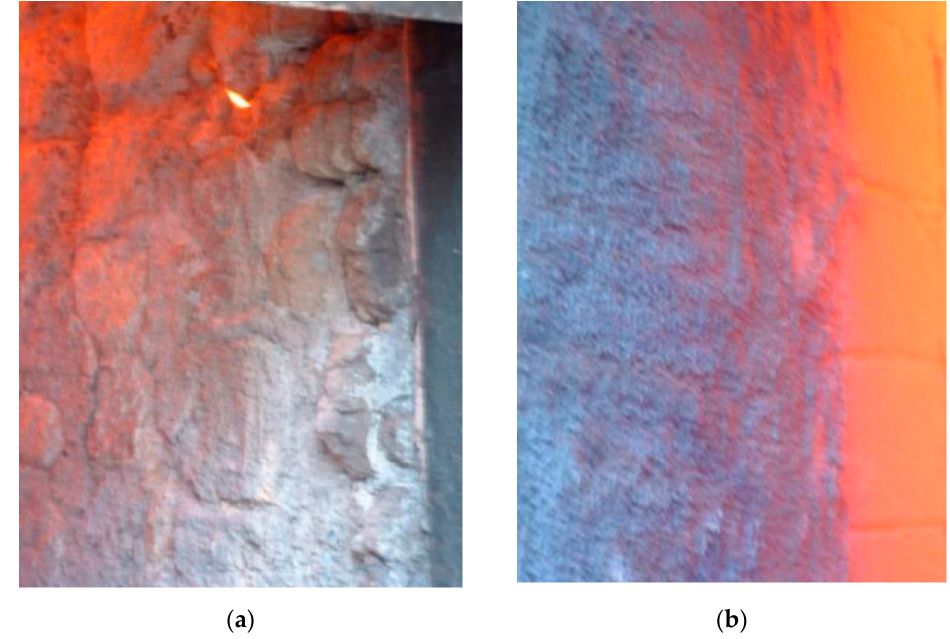
Figure 4. ( a ) Wall with damage on the refractory; ( b ) refractory repaired by ceramic welding.